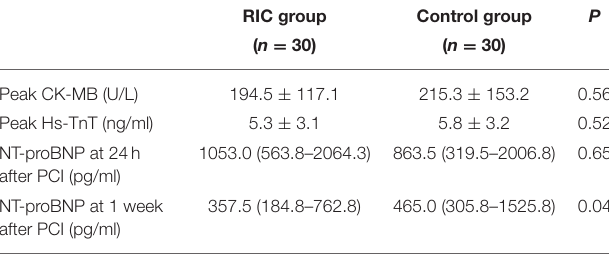
TABLE 4 | Cardiac biomarkers of the RIC group and the control